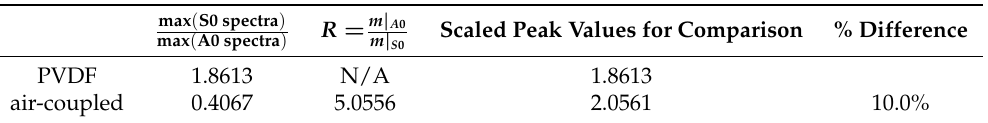
Table 1. Calculated results for scaling the peak values of the air-coupled spectra to approximate the PVDF